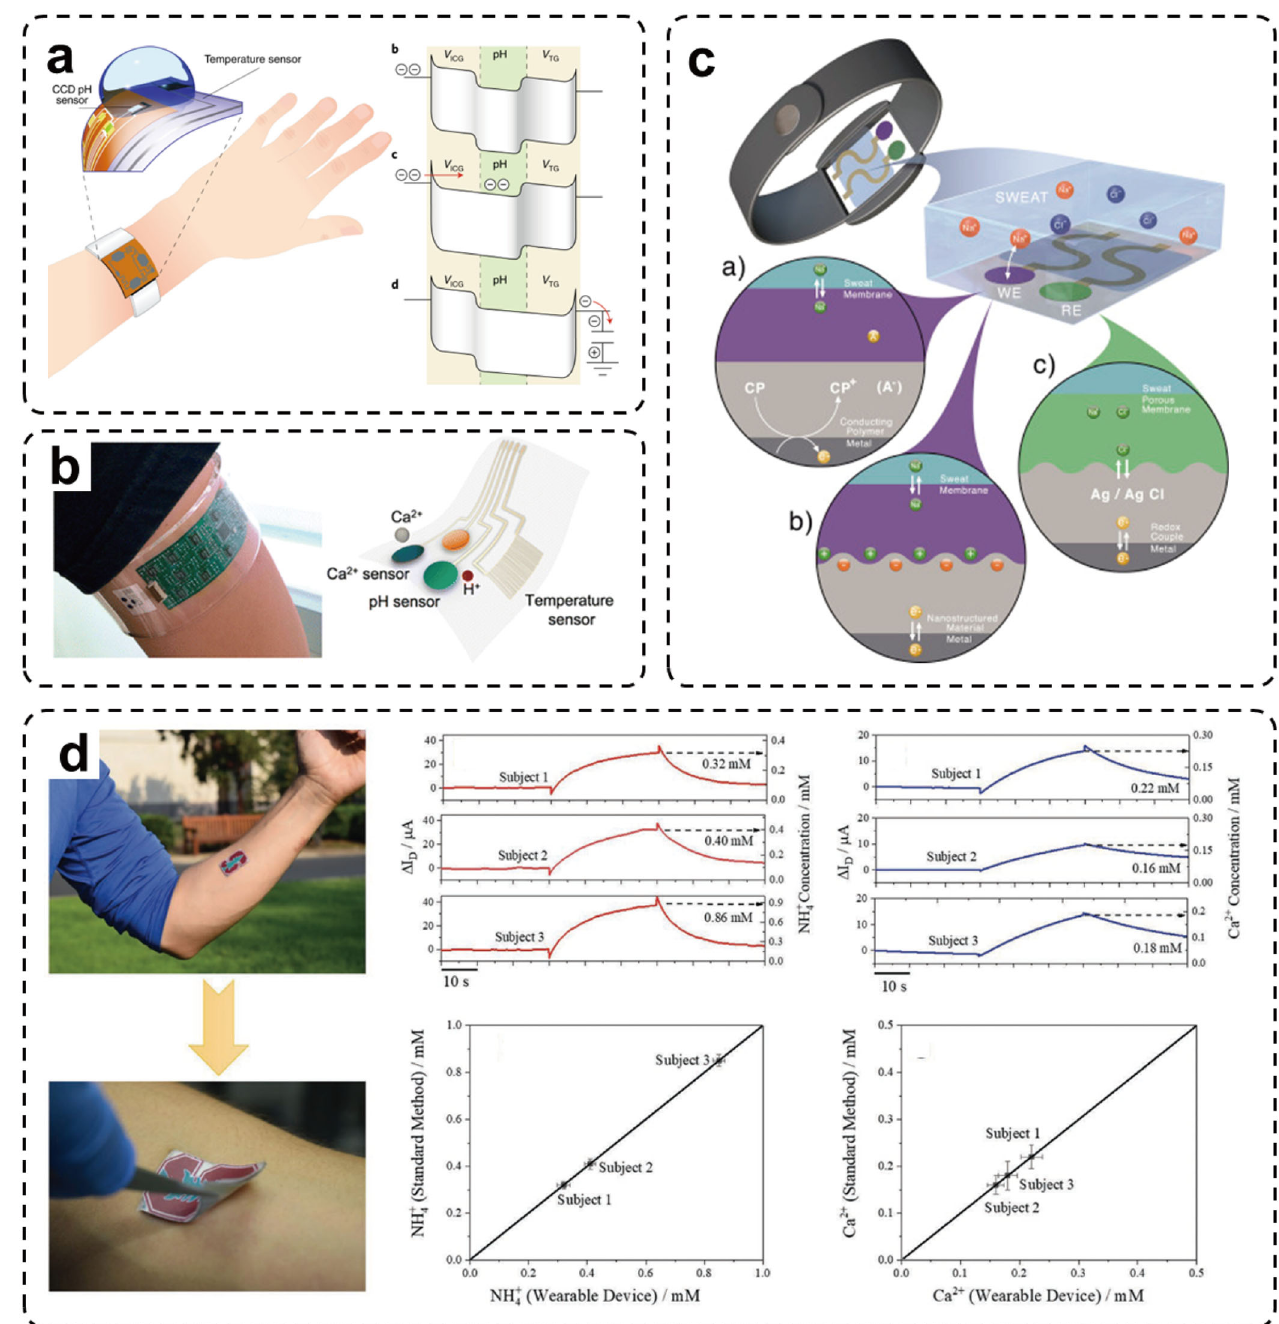
Fig. 4 Examples for electrolytes sensing. a A fl exible charge-coupled device can be used to create a sensor capable of measuring the pH of sweat with high sensitivity. Ref. 72 , Copyright 2018, Nature Electronics. b A wearable electrochemical device for continuous monitoring of ionized calcium and pH of body fl uid. Ref. 73 , Copyright 2016, ACS Nano. c Illustration of WPIS based on a bracelet that was modi fi ed with the working/indicator electrode (WE) and a reference electrode (RE) to provide a WPIS. Ref. 77 , Copyright 2018, Trends in Analytical Chemistry. d An integrated device to monitor the physiological concentration of two cations, ammonium (NH 4 + ) and calcium (Ca 2 + ). Ref. 78 , Copyright 2019 Advanced Healthcare